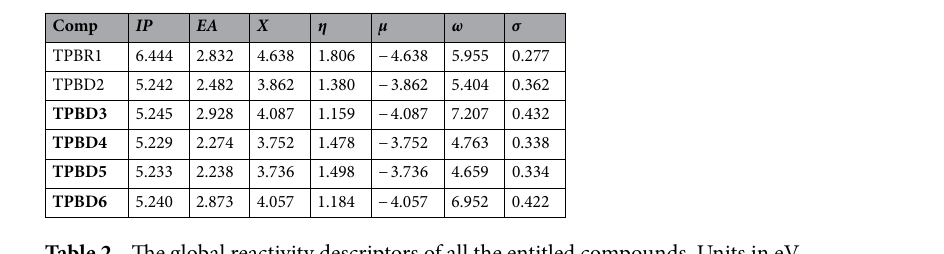
Table 2. The global reactivity descriptors of all the entitled compounds. Units in